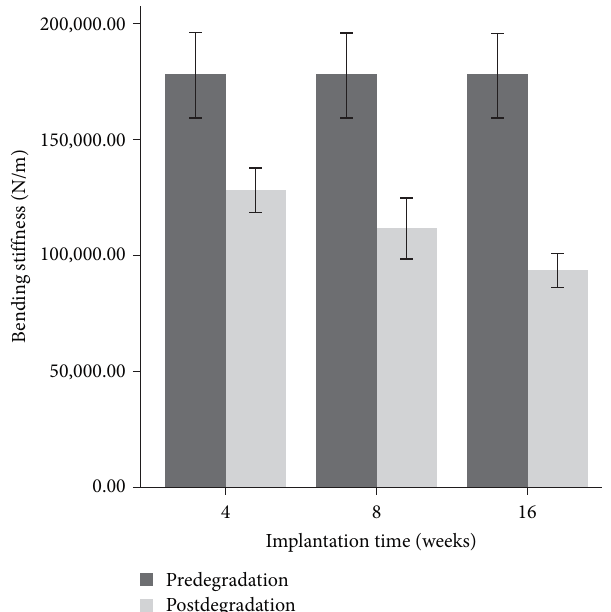
F IGURE 9: Bending stiffness of magnesium alloy plate before and at 4, 8, and 16 weeks after implantation.